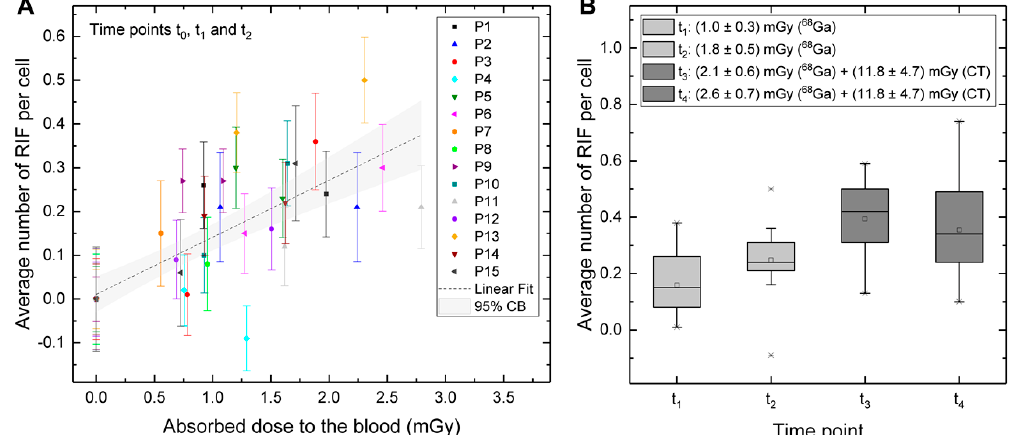
Figure 3. In vivo study—absorbed dose-dependency of the average number of RIF. ( A ) Average number of RIF per cell as a function of the absorbed dose to the blood (time points t 0 , t 1 and t 2 ) with a linear fit to the pooled data, including a 95% confidence band. ( B ) Boxplot of the average number of RIF per cell at the sampling time points t 1 to t 4 with the mean absorbed doses to the blood stated in the legend.